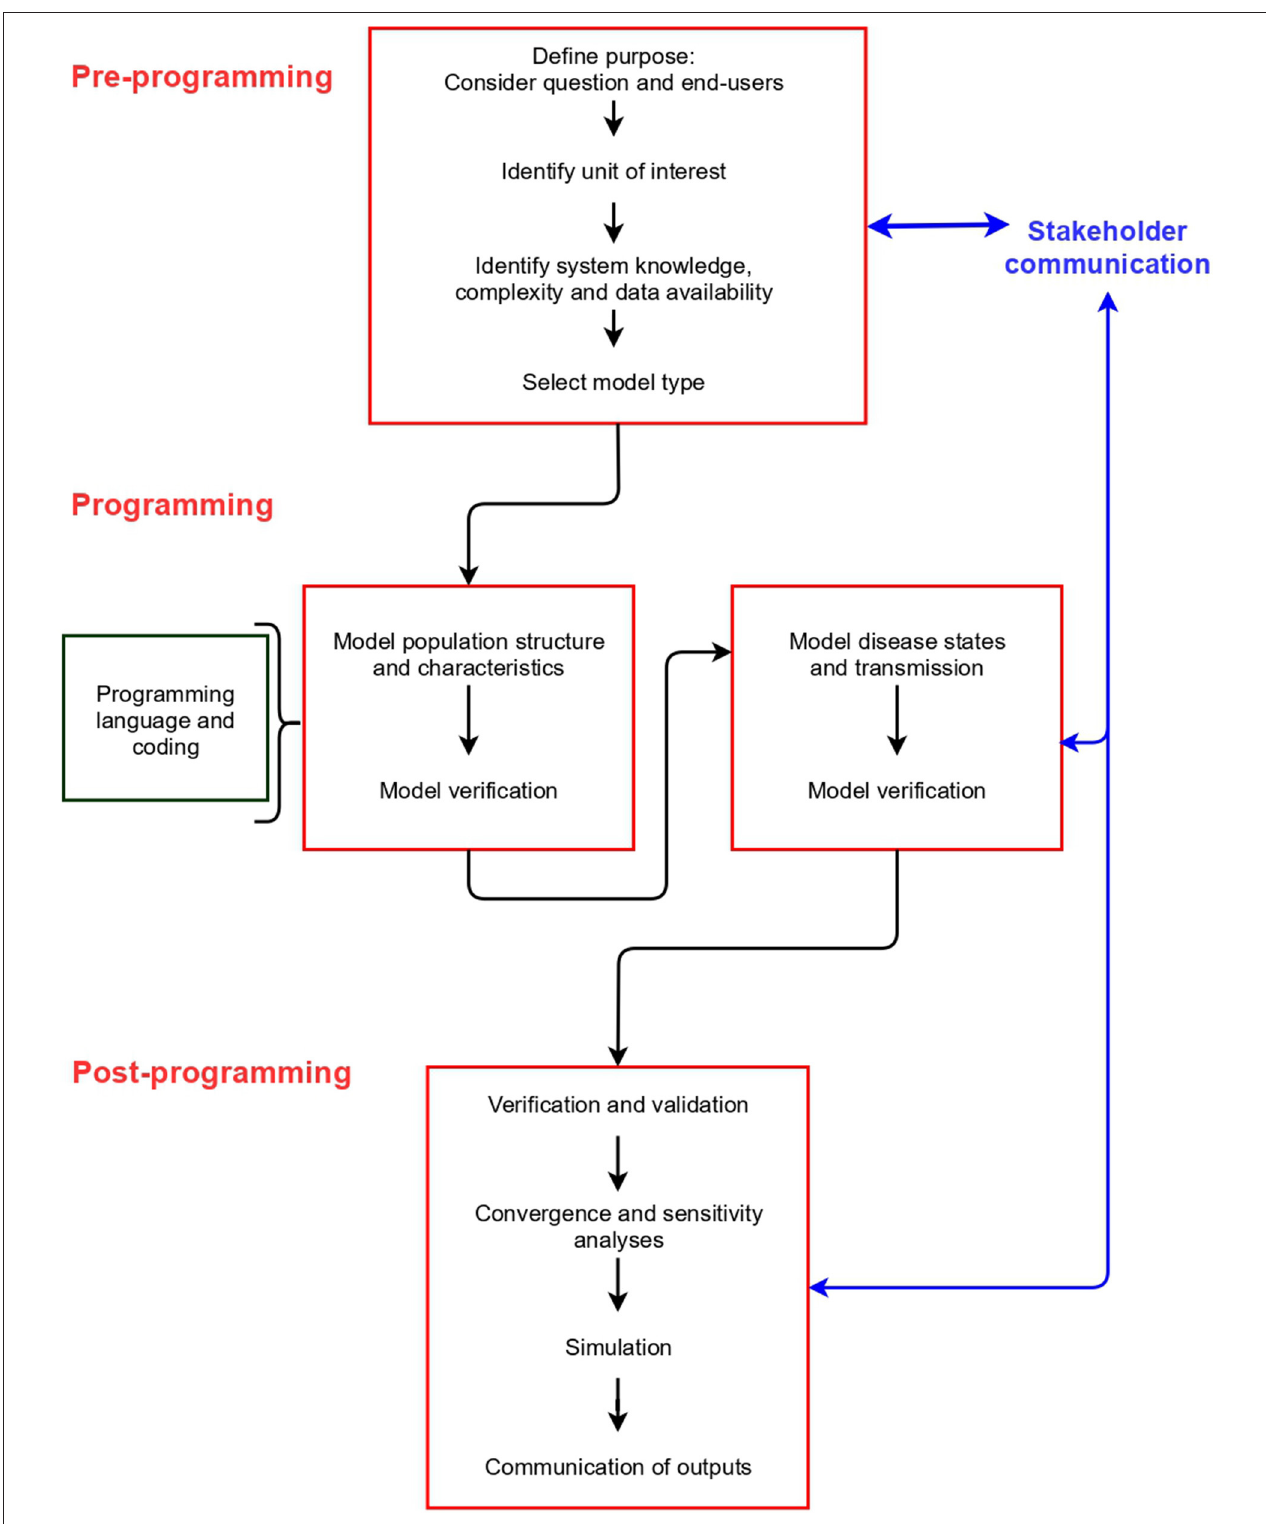
FIGURE 2 | Stages, and steps within each stage, in building a disease spread model.